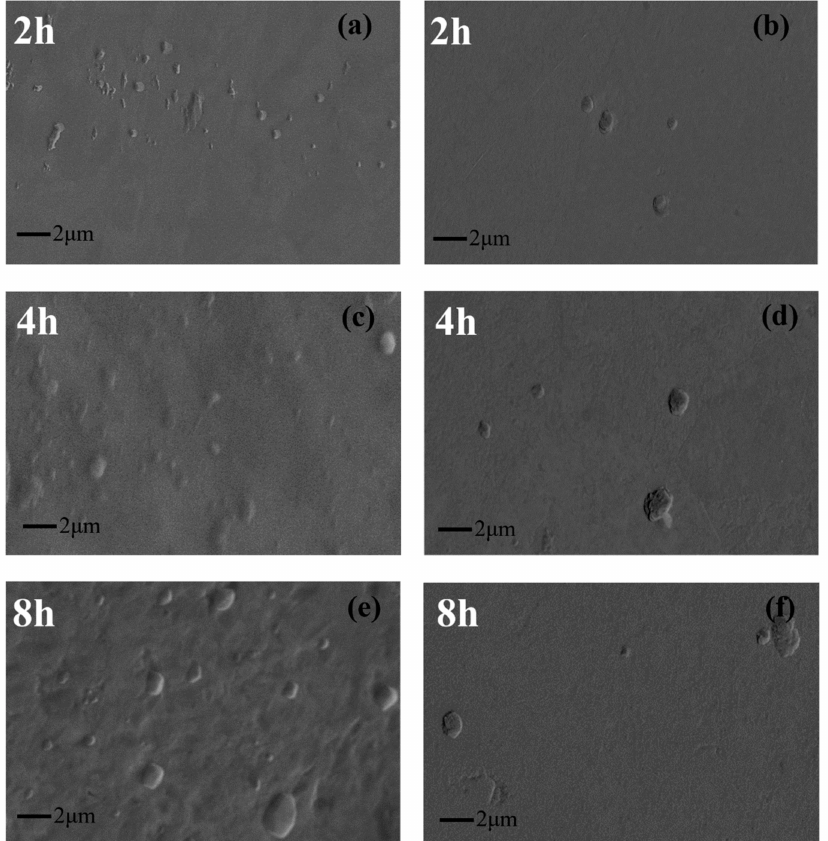
Figure 4. SEM images of the surfaces of W bulk ( a , c , e ) and nanocrystalline W films ( b , d , f ) exposed to 100 eV deuterium plasma under different fluences at 500 K: ( a , b ) irradiation for 2 h (fluence: 1.30 × 10 25 D/m 2 ); ( c , d ) irradiation for 4 h (fluence: 2.59 × 10 25 D/m 2 ); ( e , f ) irradiation for 8 h (fluence: 5.18 × 10 25 D/m 2